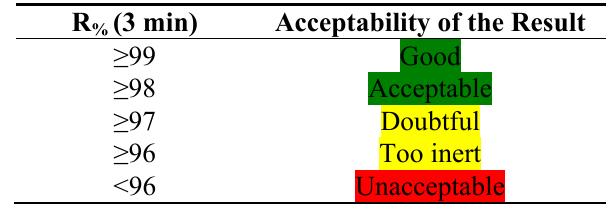
Table 13. Criteria for laboratory performance based on response factor assessment.